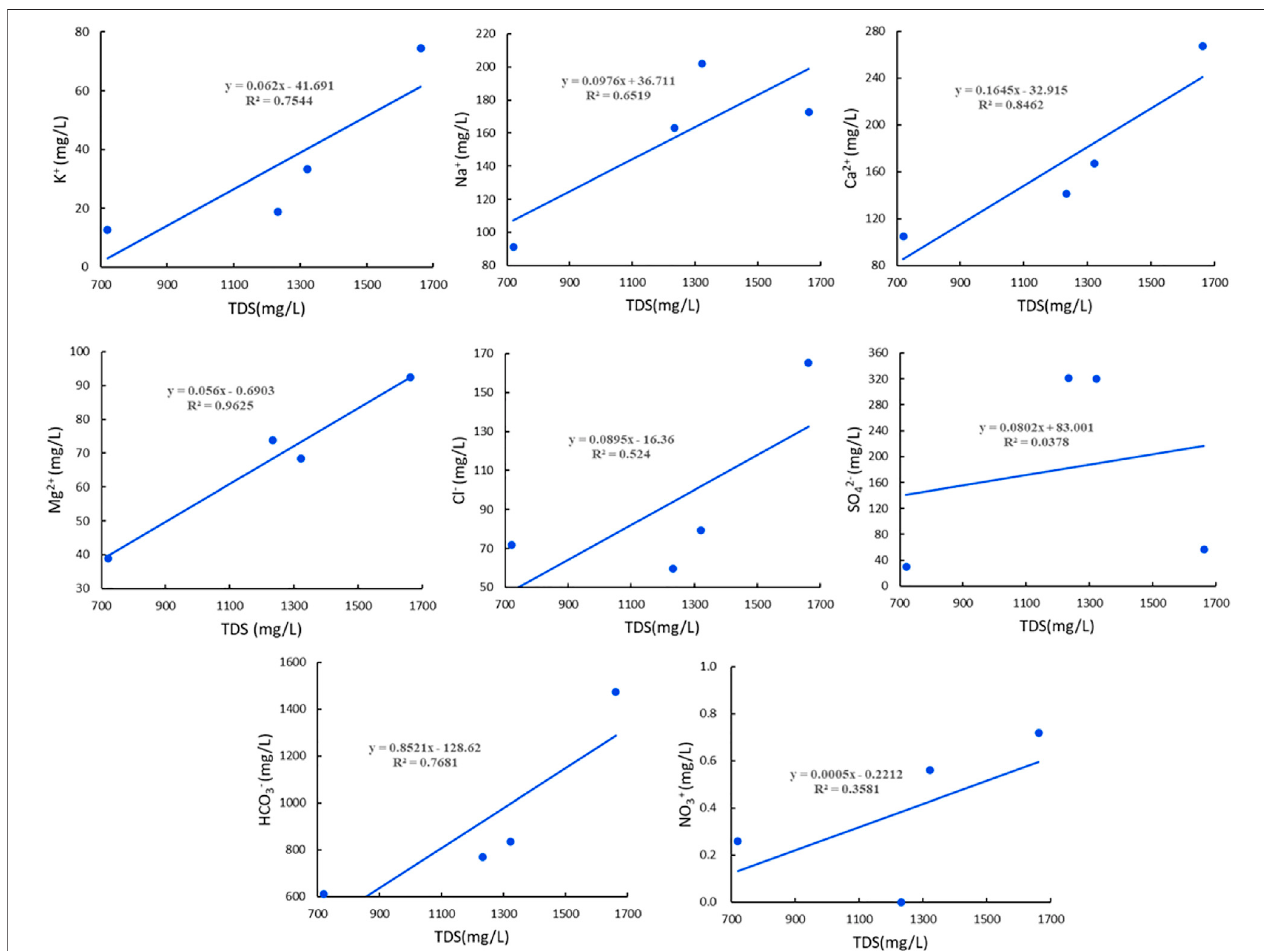
FIGURE 3 | Curves showing the correlation between ions and TDS of water samples from warm springs in the Jiangcang Basin.